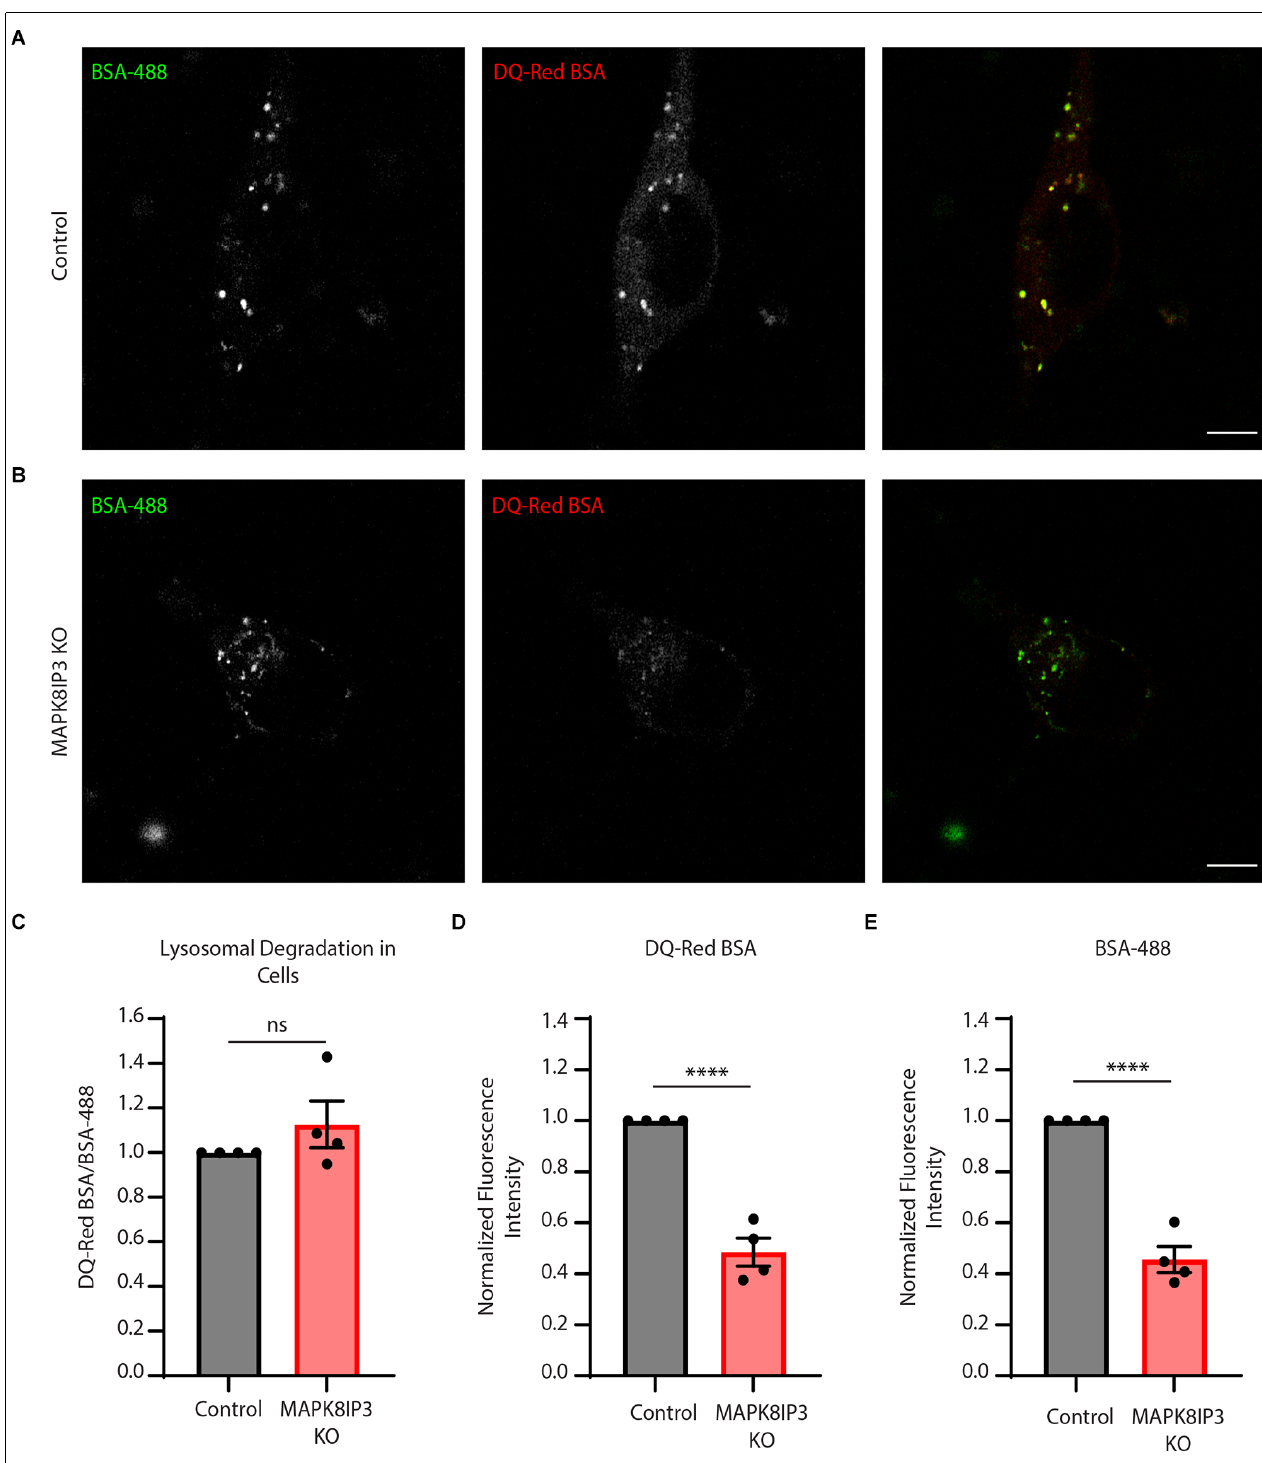
FIGURE 2 | MAPK8IP3 KO i 3 Neuron endocytic uptake is more dramatically decreased with a shorter pulse. (A,B) Representative images of Control and MAPK8IP3 KO i 3 Neurons at DIV14 after 2-h pulse with DQ-Red BSA and BSA-488, sclae bar: 5 µ m. (C) Quantification of mean normalized DQ-Red BSA/BSA-488 mean ratios in Control and MAPK8IP3 KO i 3 Neurons. (D) Quantification of DQ-Red BSA fluorescence intensity normalized to Control. (E) Quantification of BSA-488 fluorescence intensity normalized to Control. (C–E) Quantifications show mean ± SEM for two independent experiments, each with two technical repeats (**** P < 0.0001; ns, not significant; unpaired t -test). Control = 75; MAPK8IP3 KO = 54 cells.